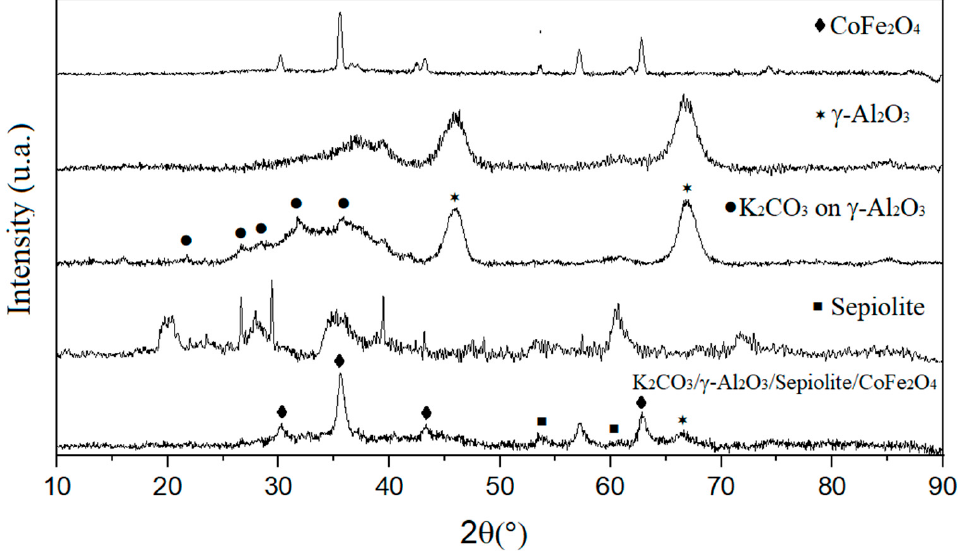
Figure 3. X-ray diffraction patterns of the cobalt ferrites and K 2 CO 3 / γ -Al 2 O 3 /sepiolite/CoFe 2 O 4 .